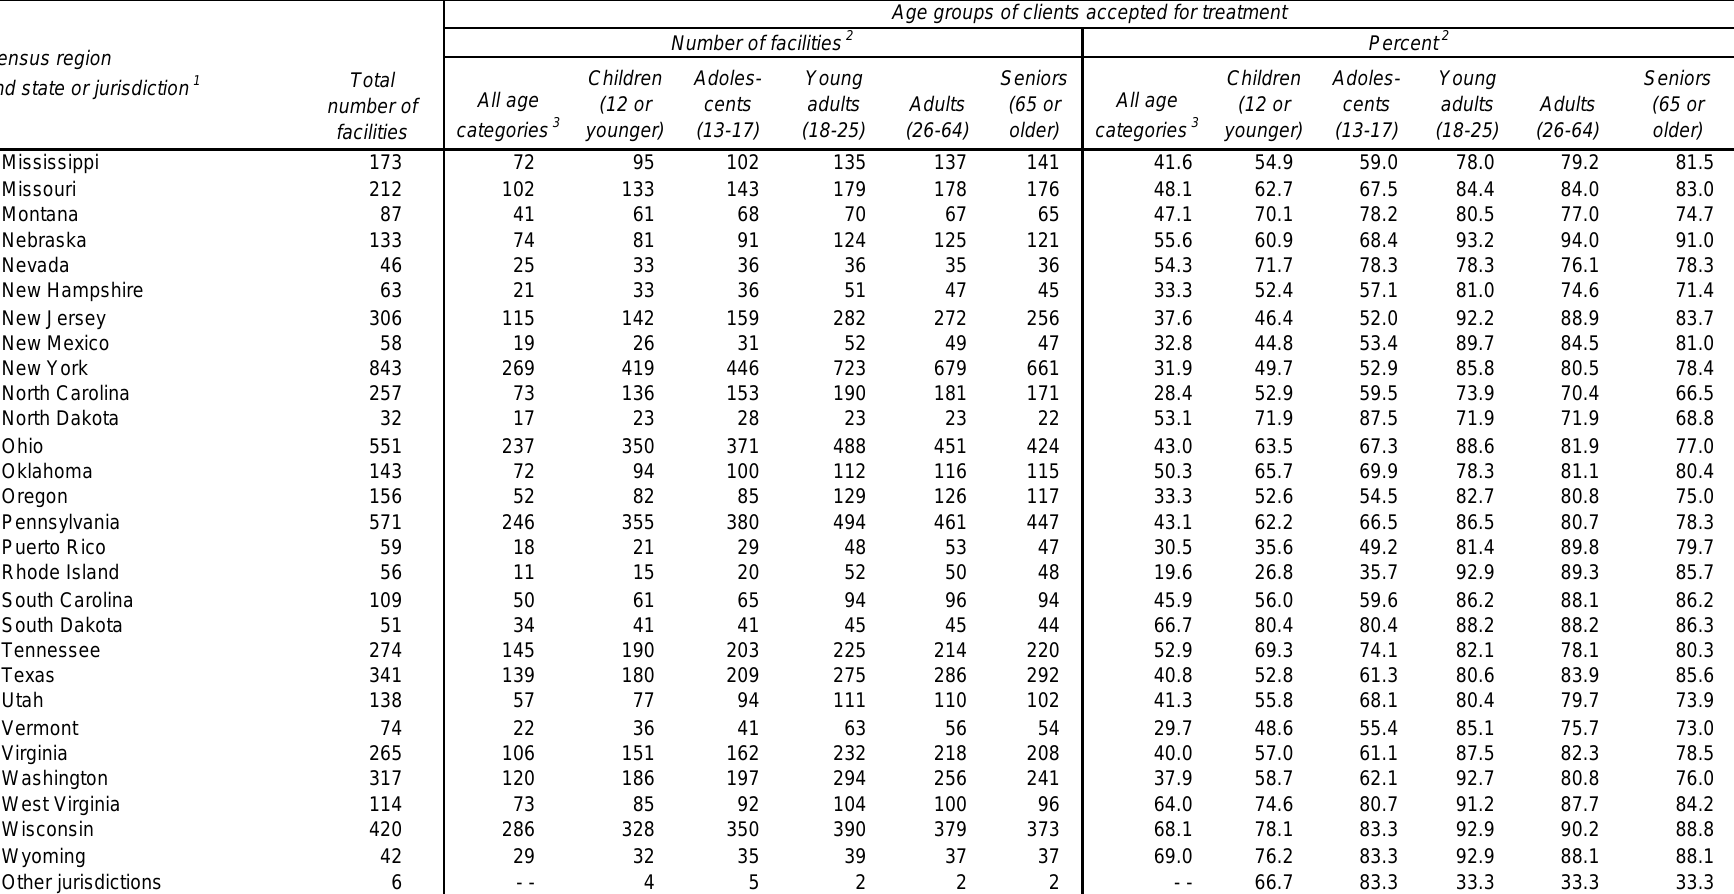
Table 3.9. Mental health treatment facilities accepting specific age groups for treatment, by Census region and state or